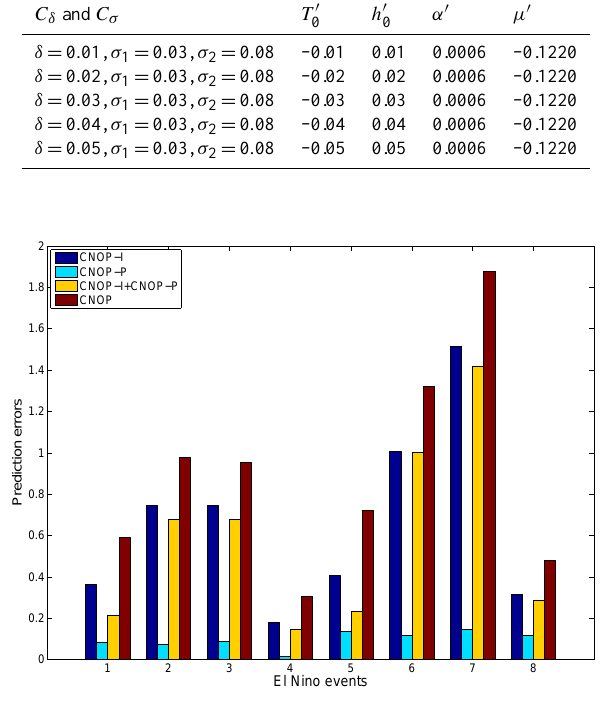
Fig. 1. Magnitudes of prediction errors caused by the CNOP- I, CNOP-P, CNOP errors, and the combination of CNOP-I and CNOP-P errors with δ = 0 . 05 and σ 1 = 0 . 03 and σ 2 = 0 . 08, for the predetermined eight model El Ni˜no events. The measurement of the p T 0 (τ) 2 + h 0 (τ) 2 . The numbers 1, prediction errors is J(u 0 ; p 0 ) = 2, 3 and 4 in the horizontal axis denote the El Ni˜no events U W U W , U W and U W ; and 5, 6, 7 and 8 signify the El Ni˜no events Apr Jul Oct U S , U S , U S and U S , Jan Apr Jul Oct